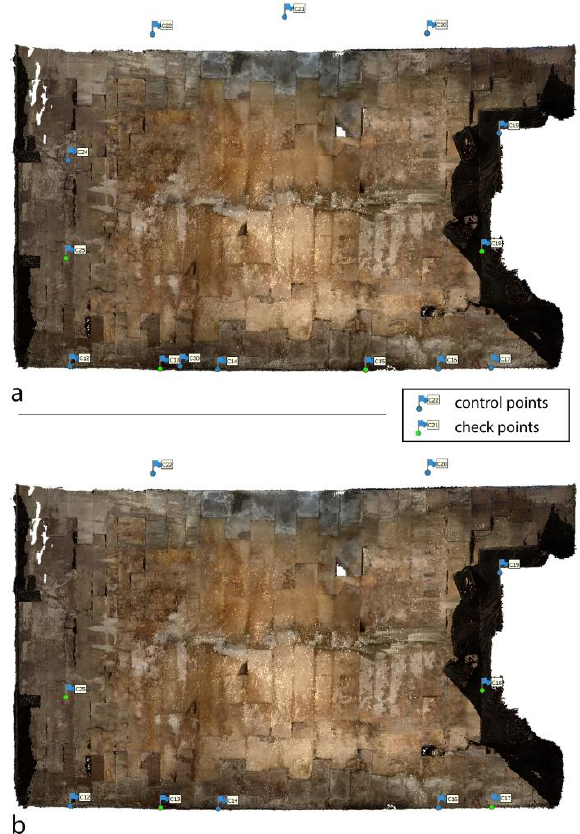
Figure 3. Distribution of control and check points on the arch for the processing of the survey with SLR (a) and the one with the action camera (b).